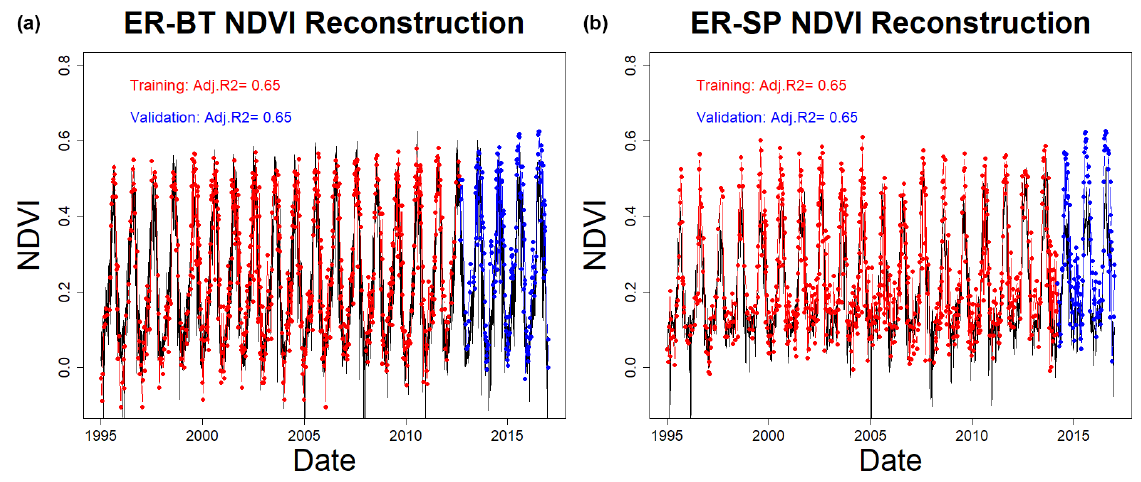
Figure 4. Temporal reconstruction of NDVI at ER-BT (a) and ER-SP (b) . Black lines represent reconstructed daily NDVI. Red points are used for training, and blue points are used for